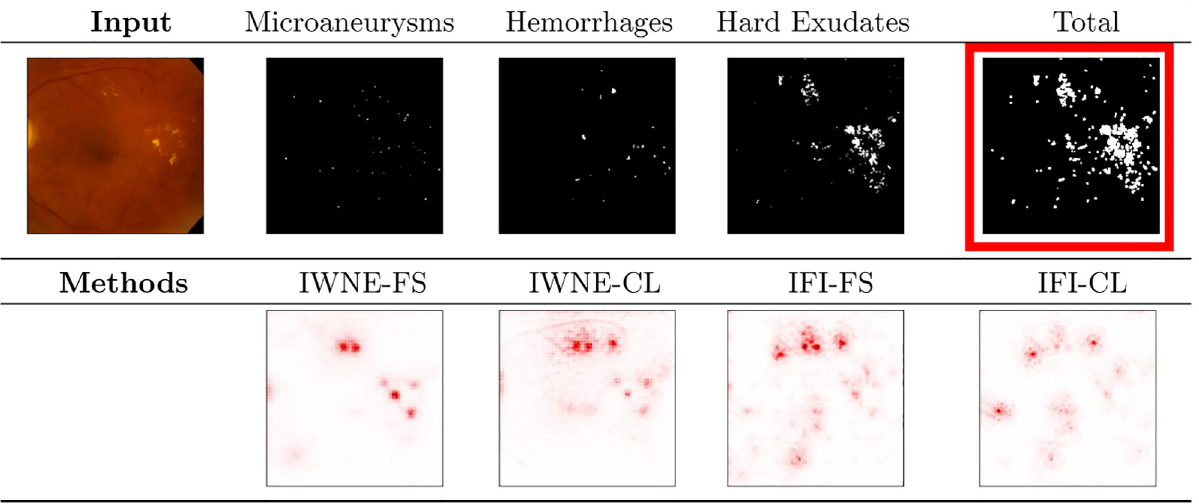
Fig 5. Top left image in the figure shows the input followed by the segmentation maps from the IDRiD dataset. Top right image is the total that we compute by combining the segmentation maps of different lesions. Bottom row shows the explanation heatmaps for the given input. Each explanation heatmap is correlated with the total image marked in red to evaluate the effectiveness of the model towards making the prediction for the disease. We find that IWNE-FS overfits on the hard exudates and also fails to pick up on cues related to microaneurysms. We also find that explanation heatmaps of IFI models show reduced signs of overfitting to a single lesion when compared to